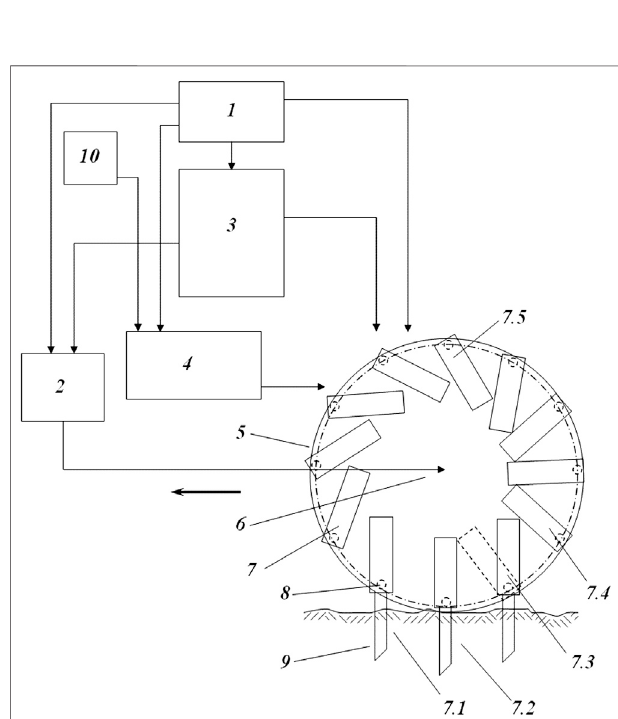
FIGURE 3 | Robotic device for carrying out intra-soil pulse continuous- discrete watering and at the same time supplying the soil with